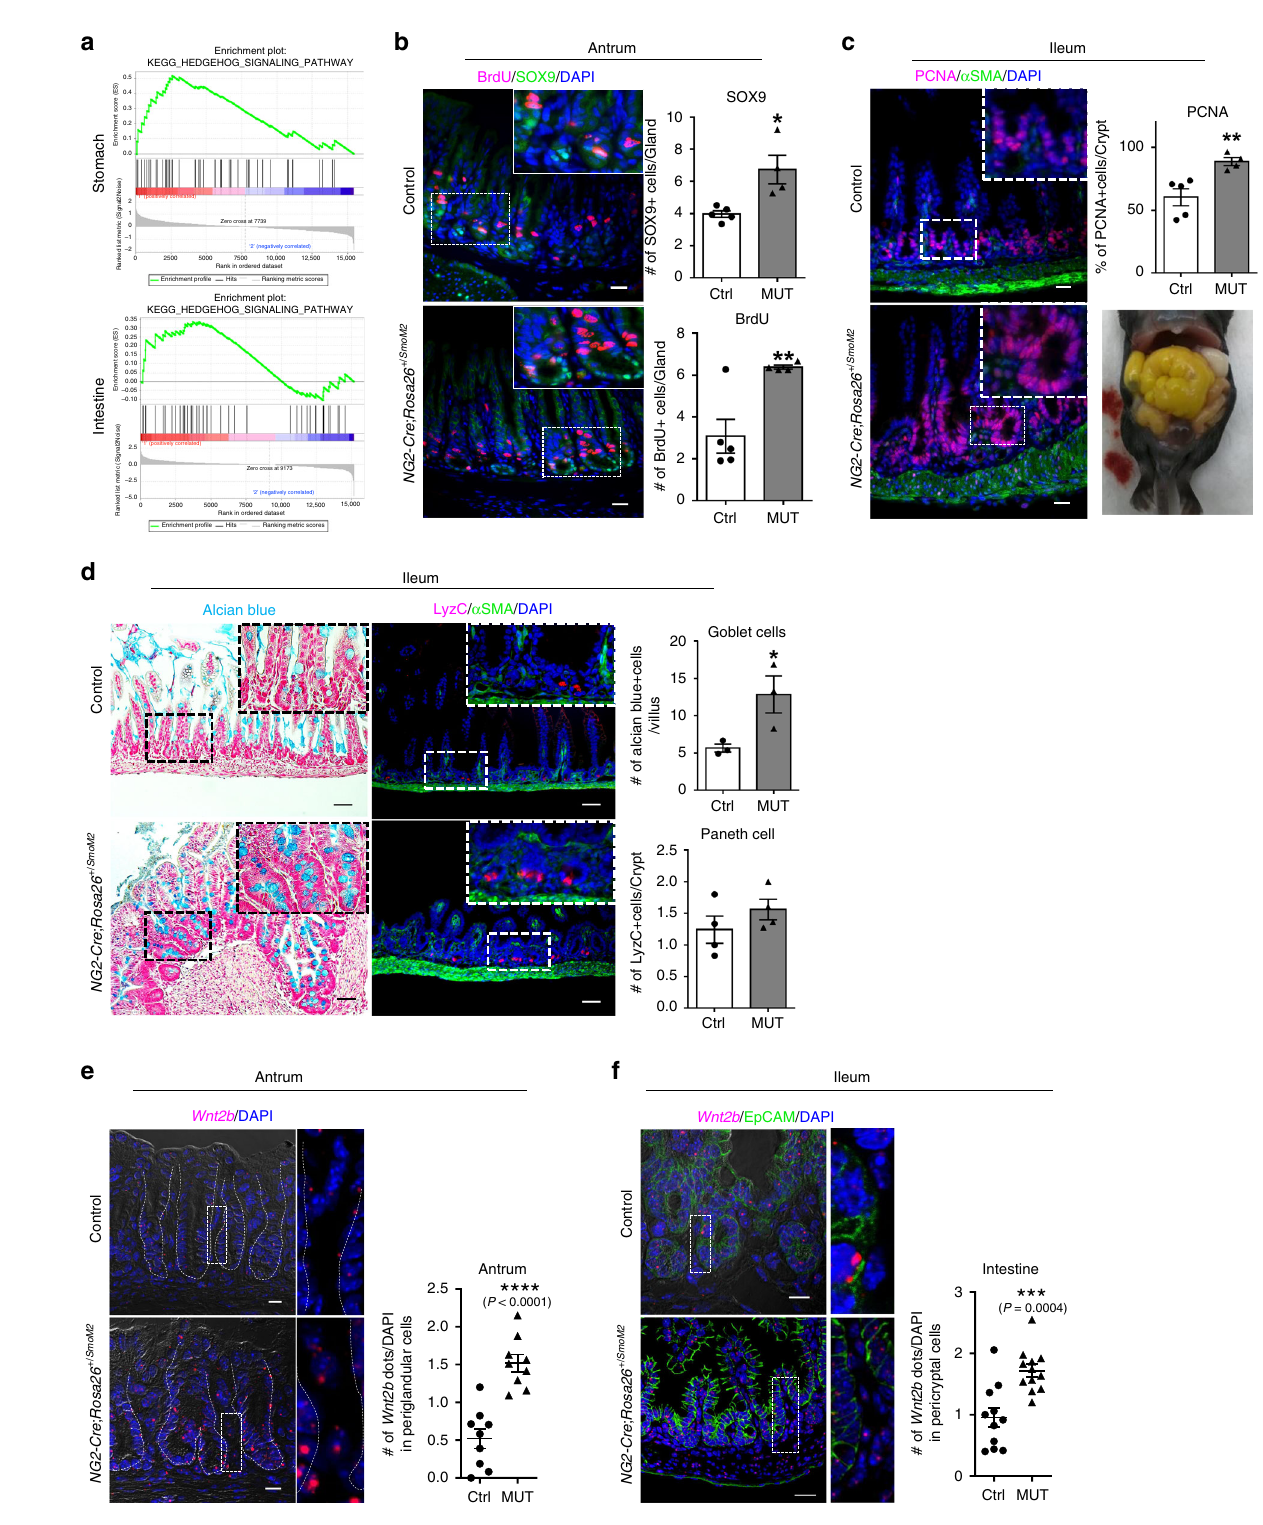
regions near Wnt2b and Wnt9a loci into plasmids containing a Fig. 20, 30). Together, this work reveals that the GLI2-mediated luciferase reporter gene and performed a transcriptional reporter transcriptional activation of stromal Wnt niche signals, and this assay upon co-expression of Gli2 . We con fi rmed GLI2 activation direct regulation in gut stromal cells is conserved between the of these reporter genes in gastrointestinal mesenchymal cells stomach and intestine. (Fig. 6h, i; Supplementary Fig. 29). Corroborating this data, the expression of Gli2 was enriched in Ng2-Cre labeled and Cspg4 Redundant role of stromal Wnt secretion in gut development . ( Ng2 ) expressing pericyte-like stromal cells (Supplementary Although this study has revealed conserved signaling mechanisms NATURE COMMUNICATIONS| (2020) 11:334